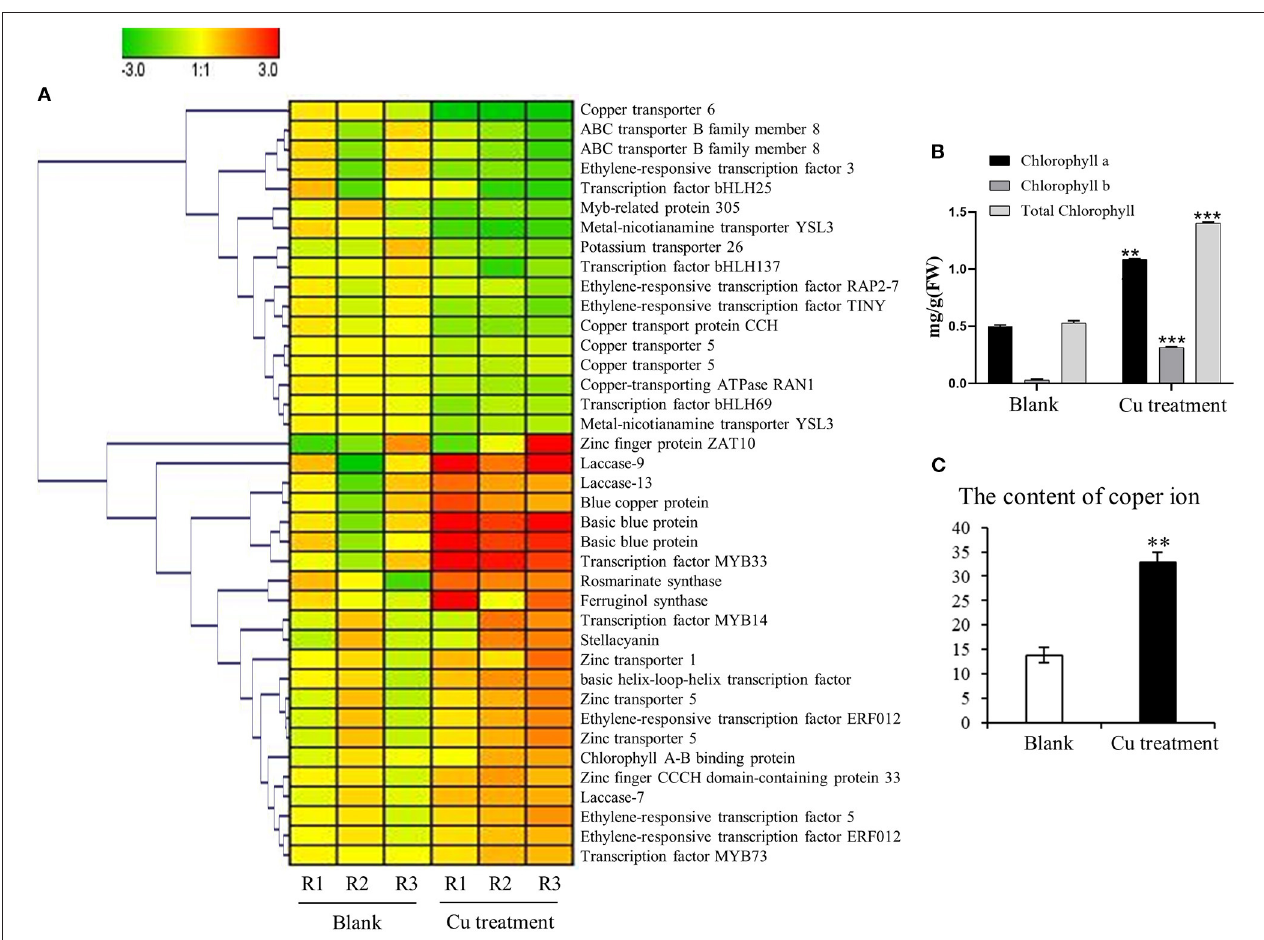
FIGURE 5 | Impact of the copper treatment on biosynthesis of salvinolic acids (SalAs), chlorophyll metabolism, and ion transport. (A) The change tendency of differentially expressed genes involved in the biosynthesis of SalAs, chlorophyll metabolism, and ion transport was analyzed based on their expression levels in untreated and treated samples. (B) The content of chlorophyll a , chlorophyll b , and total chlorophyll in untreated and treated samples was determined. (C) The content of copper ions in untreated and treated samples was measured. Data represent the mean ± SD of three independent biological replicates. Significant differences between treatment and control samples were determined using a Student’s T -test (** P < 0.01, *** P < 0.001).